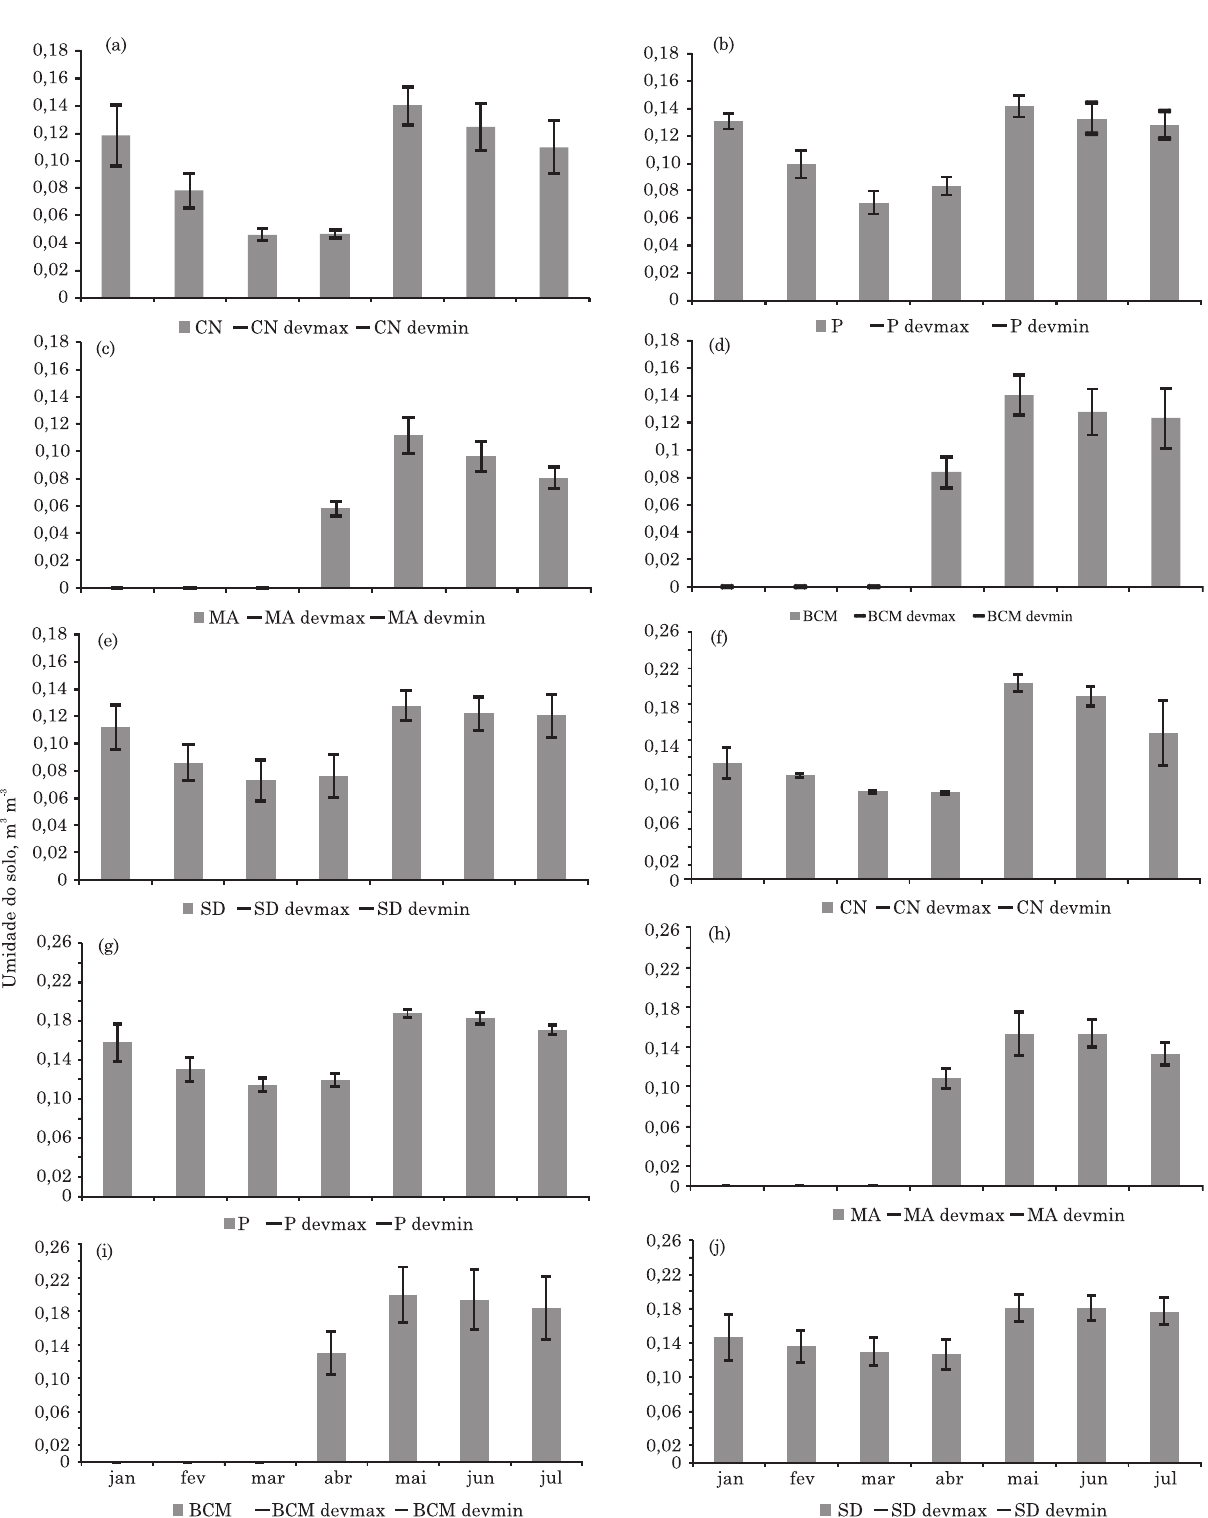
Figura 3. Variação da umidade do solo para o Argissolo Amarelo eutrófico abrúptico nos tratamentos, de janeiro a julho de 2011. Na profundidade de 20 cm: (a) Cobertura natural (CN); (b) Palma (P); (c) Morro abaixo (MA); (d) Barramento com cobertura morta (BCM); e (e) Solo descoberto (SD); na profundidade de 40 cm: (f) Cobertura natural (CN); (g) Palma (P); (h) Morro abaixo (MA); (i) Barramento com cobertura morta (BCM); e (j) Solo descoberto